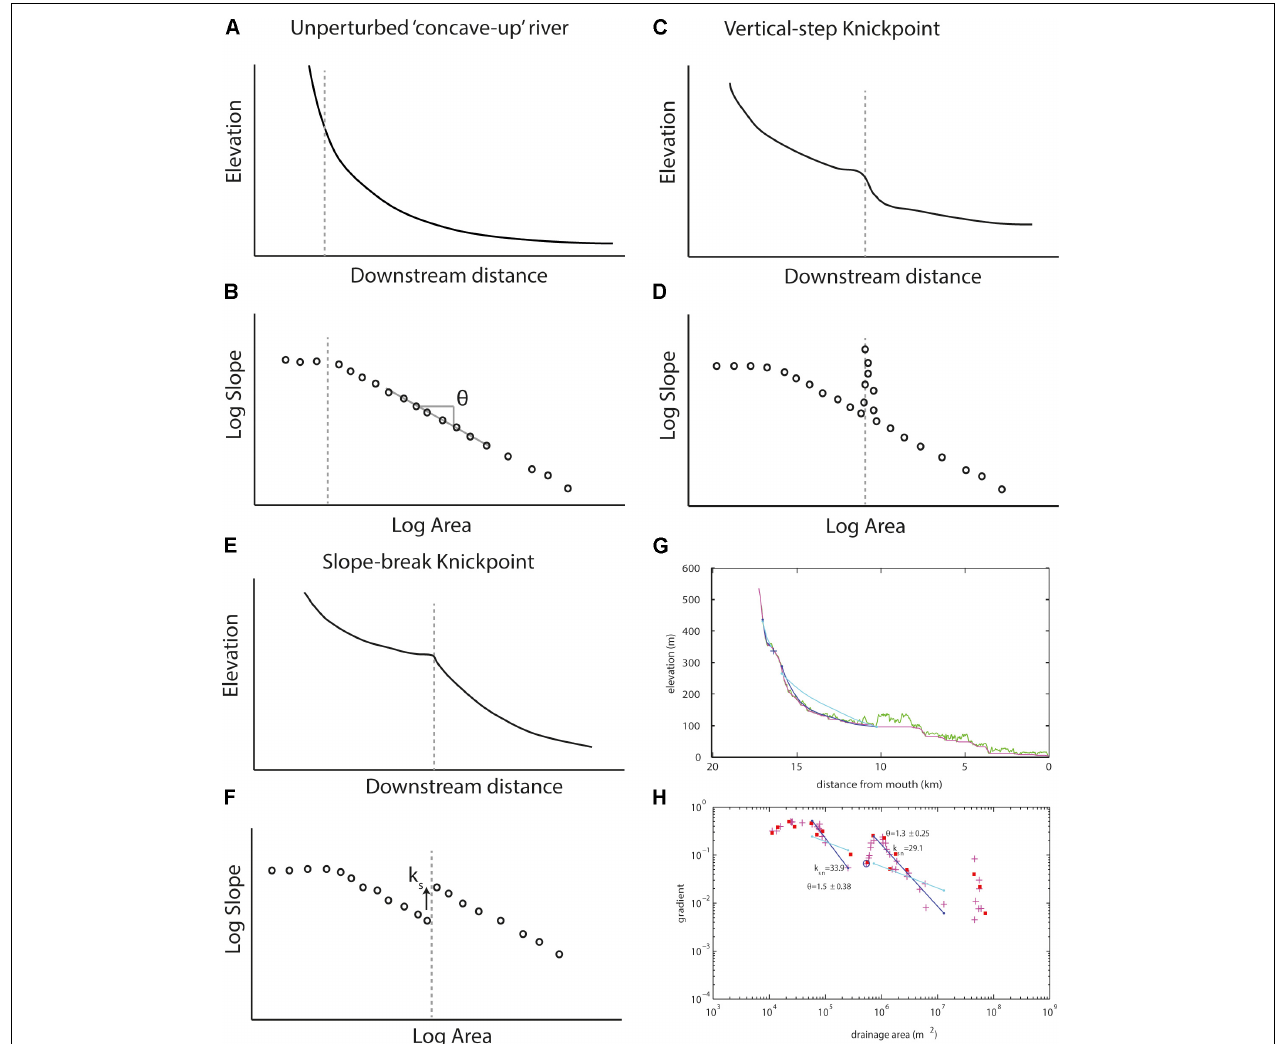
FIGURE 3 | Conceptual diagram showing the river long profile and slope-area graphs for rivers in steady state (A,B) , rivers with a vertical step knickpoint (C,D) and rivers with a slope-break knickpoint (E,F) (adapted from Wobus et al., 2006; Kirby and Whipple, 2012). Note that the steepeness index (the intercept - k s ) increases downstream across a slope-break knickpoint but not across a vertical step knickpoint. (G,H) Show an example of a river profile and slope-area plot, respectively, from the study area. This is river 21 from the island of Makira, the green line is the raw DEM river profile and the purple is the smoothed